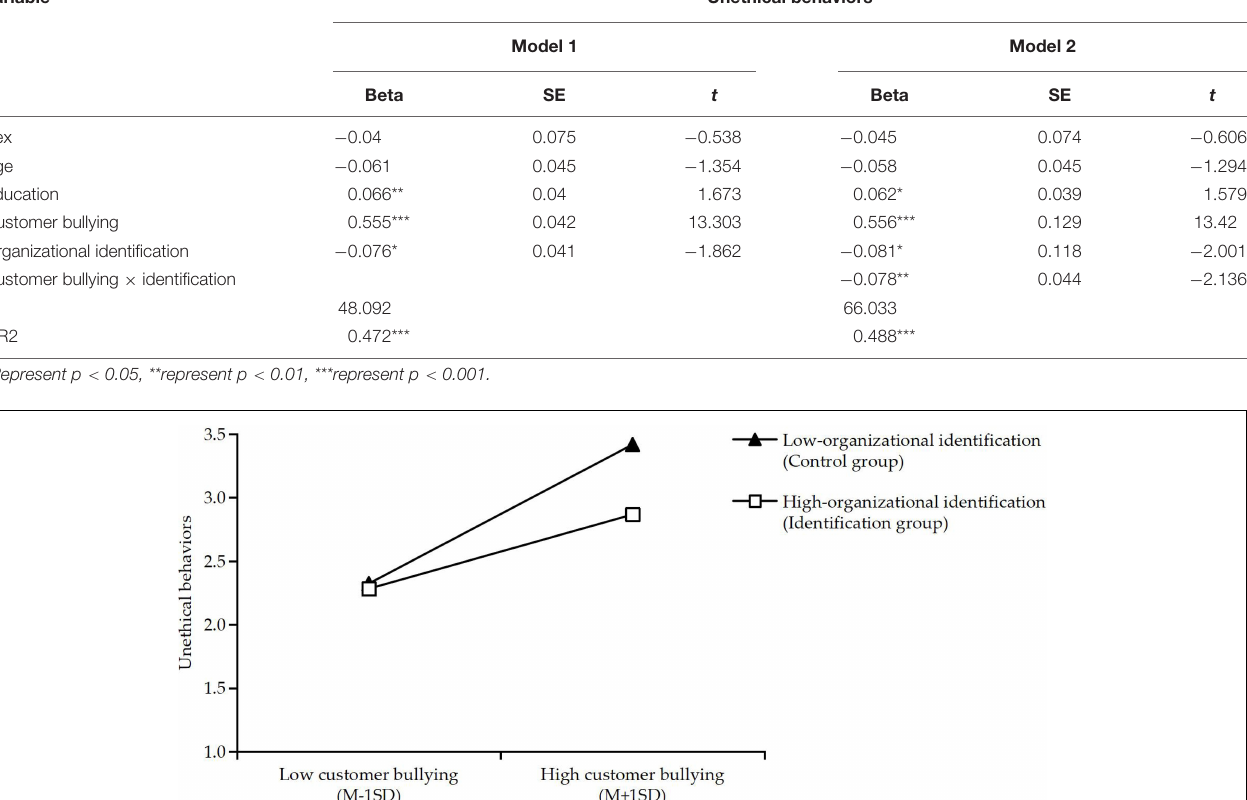
Frontiers in Psychology |